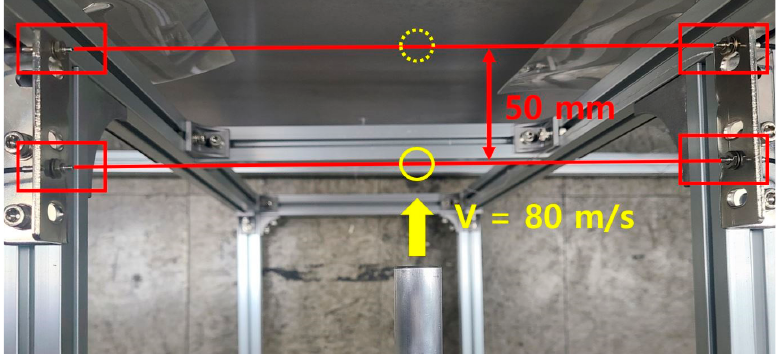
Figure 15. Measurement of steel ball velocity.